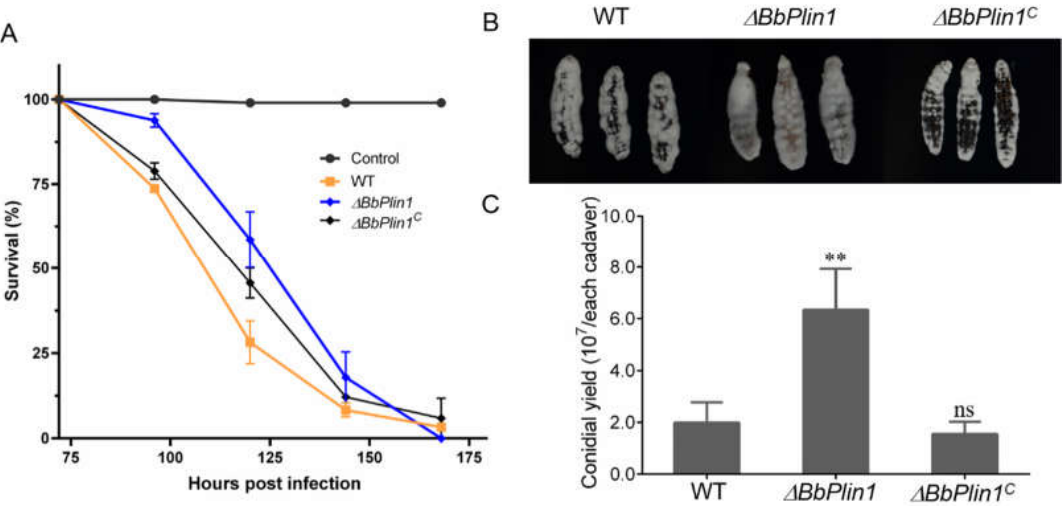
Figure 4. Insect bioassays: virulence analyses of wild–type B. bassiana and ∆ BbPlin1 . ( A ) Insect survival curves and treatment with conidial suspensions (1 × 10 7 conidia/mL) of indicated strains topically inoculated onto G. mellonella larvae, with survival recorded every 24 h. ( B ) Representative images of fungal growth on cadavers 5 d post–death. ( C ) Quantification of fungal conidial production on cadavers 20 d post–death. Fungal conidia were harvested from 2–week–old PDA plates of B. bassiana wild–type (WT) strain and mutants ( ∆ BbPlin1 , ∆ bbPlin1 C ) grown at 26 ◦ C. All